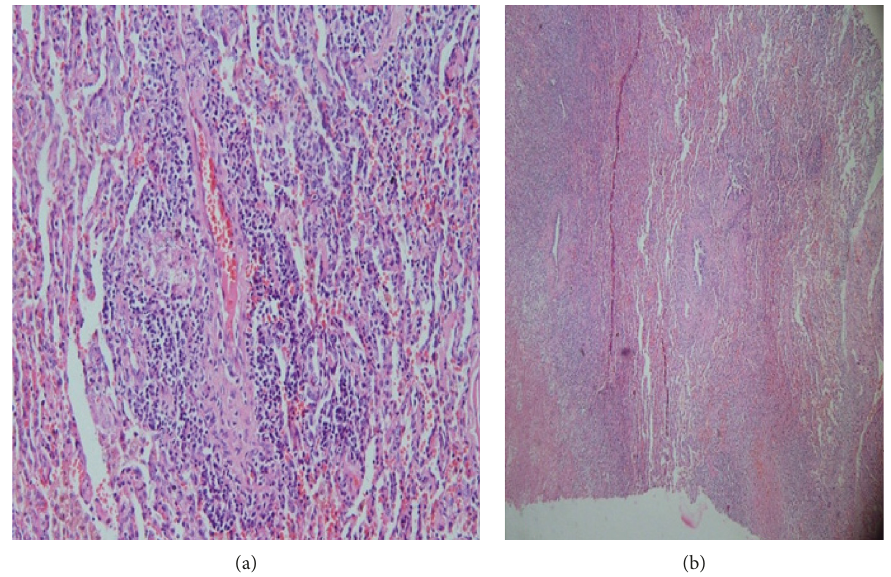
Figure 3: Necrotizing sarcoid granulomatosis vasculitis; the inflammatory infiltrate is confined to the artery wall.